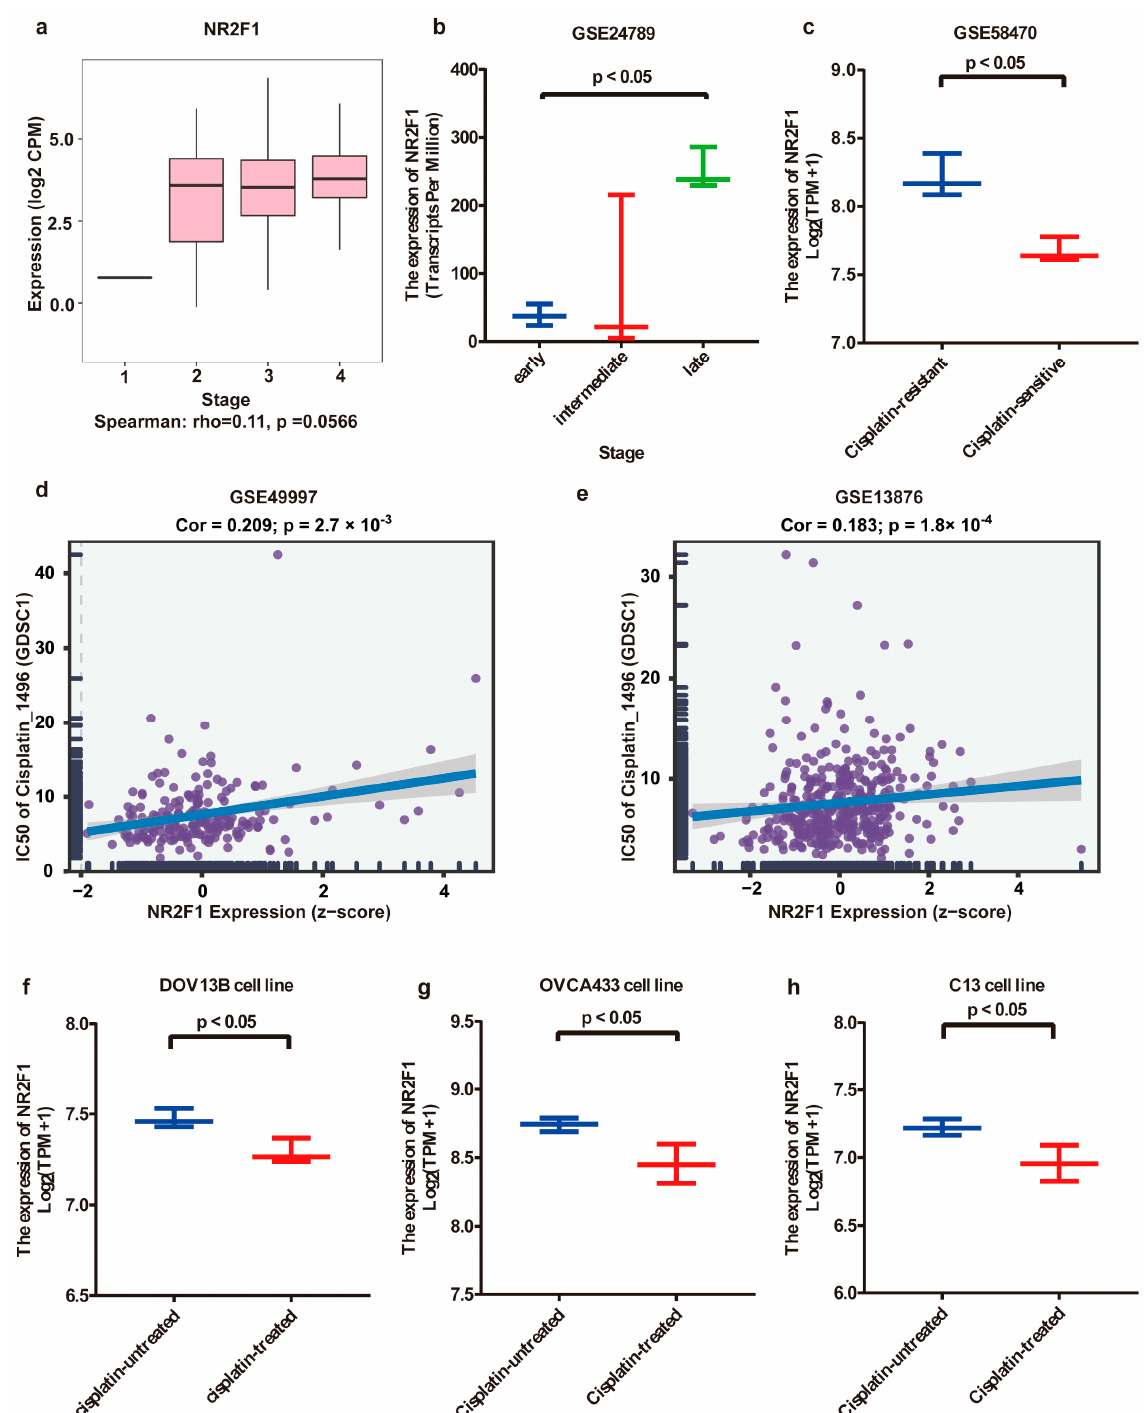
Figure 3. The association of NR2F1 with OC progression and cellular response to platinum treatment. ( a ) NR2F1 expression tendency in OC tissues at different clinical stages by TISIDB. ( b ) NR2F1 expression tendency in mouse ovarian surface epithelial (MOSE) cells at different stages based on GSE24789. ( c ) Confirmation of the elevated NR2F1 expr-ession in cisplatin-resistant OC cell lines using GSE58470. ( d , e ) Scatter plots of the association between NR2F1 expression and IC50 values of cisplatin in GSE49997 and GSE13876 datasets. ( f – h ) Changes in NR2F1 expression levels in OC DOV13B, OVCA433 and C13 cell lines following cisplatin